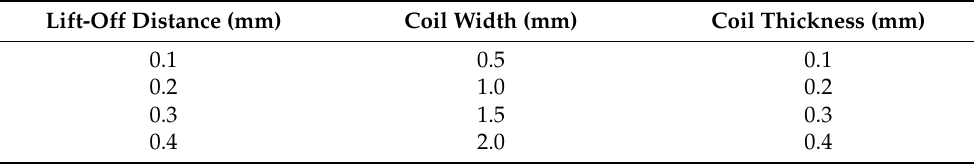
Figure 18. Parameters affecting the amplitude of surface wave. Fig. 17 Parameters that affect the amplitude of surface waves Table 1. The value range of the three parameters to be optimized.